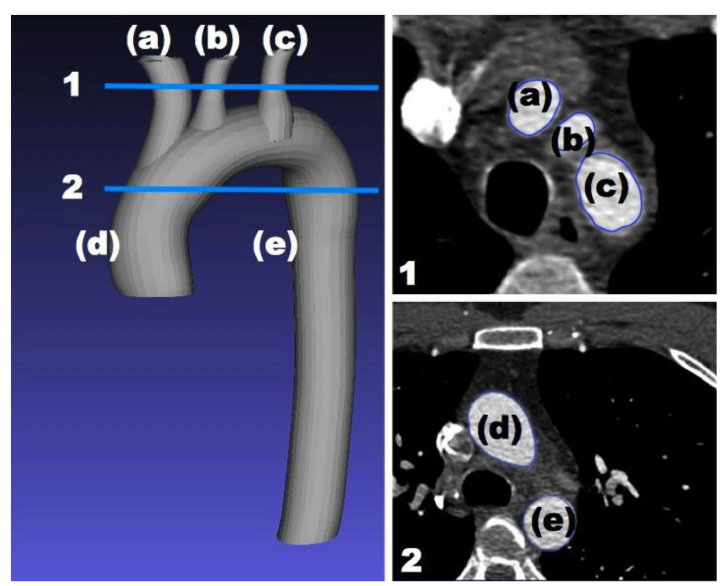
Fig. 1.2 - Substructures of the heart model in this study shown in relation to two slices out of the 400 slices of computed tomography scans. The structures are the ascending aorta (d), descending aorta (e), subclavian artery (a), left common carotid artery (b), and brachiocephalic artery (c). The two slices were captured on a two-dimensional plane marked with horizontal lines (1&2).